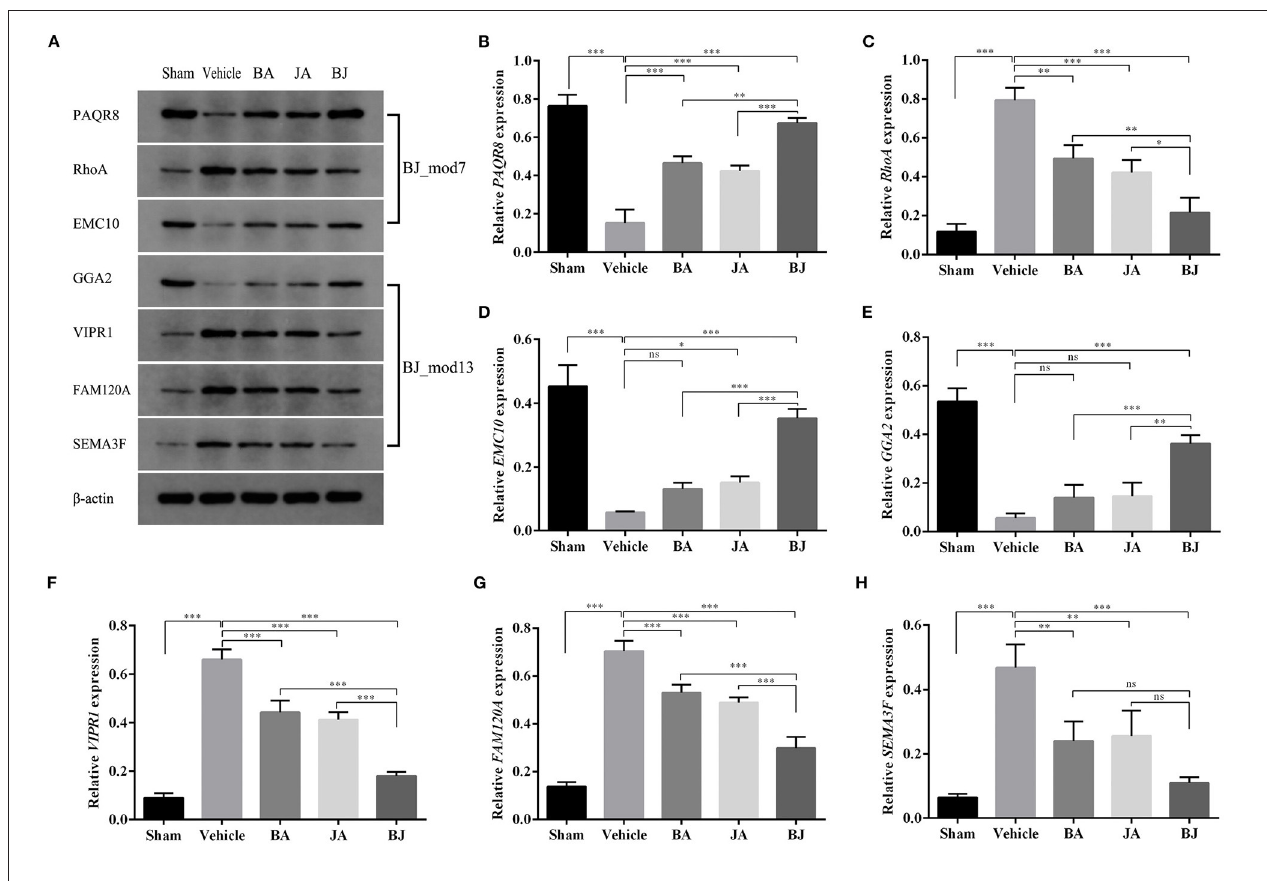
FIGURE 7 | Validation of the driver proteins’ expression level in each group. (A) The band diagrams of 7 representative driver proteins and β -actin in each group. (B–H) The expression level comparison among groups for PAQR8, RhoA, EMC10, GGA2, VIPR1, and FAM120A, SEMA3F determined by western blot. * p < 0.05, ** p < 0.01, *** p < 0.001, and ns,